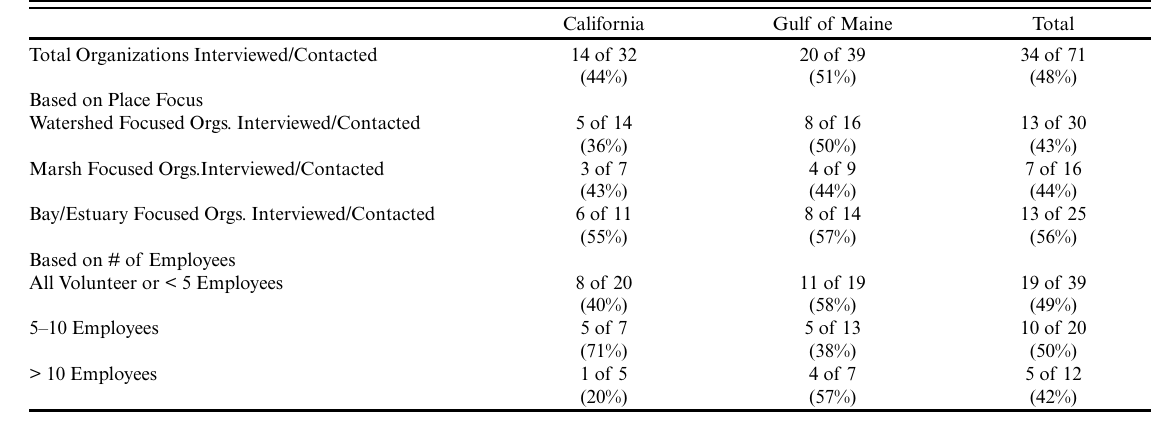
Table 1 . Interview response rate from organizations